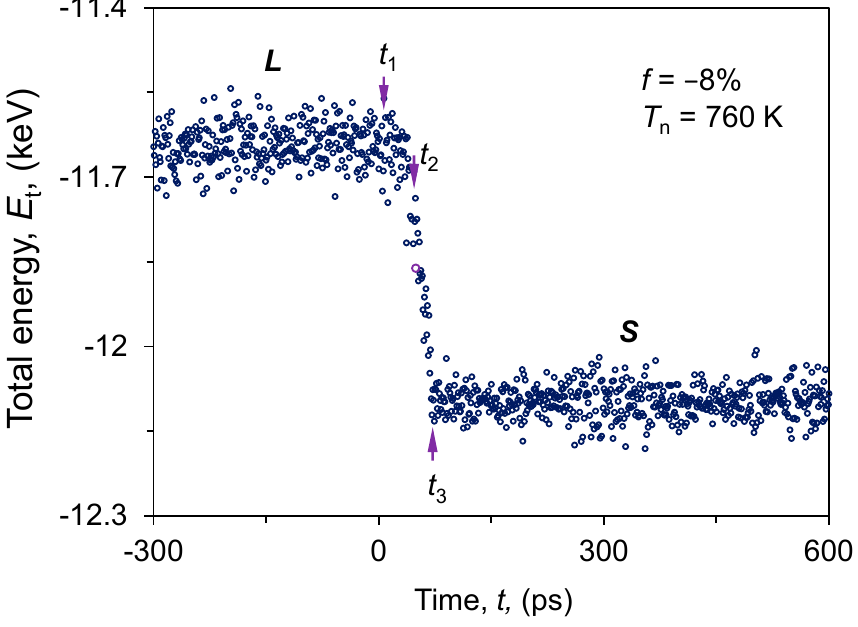
Figure 1. Evolution of total energy ( E t ) of the system with f = − 8% during the simulation at T n = 760 K. t = 0 marks the onset of nucleation, t 1 marks the onset of nucleation, t 2 the end of nucleation and t 3 the end of solidification. L and S denote the liquid and the solid phases, respectively.